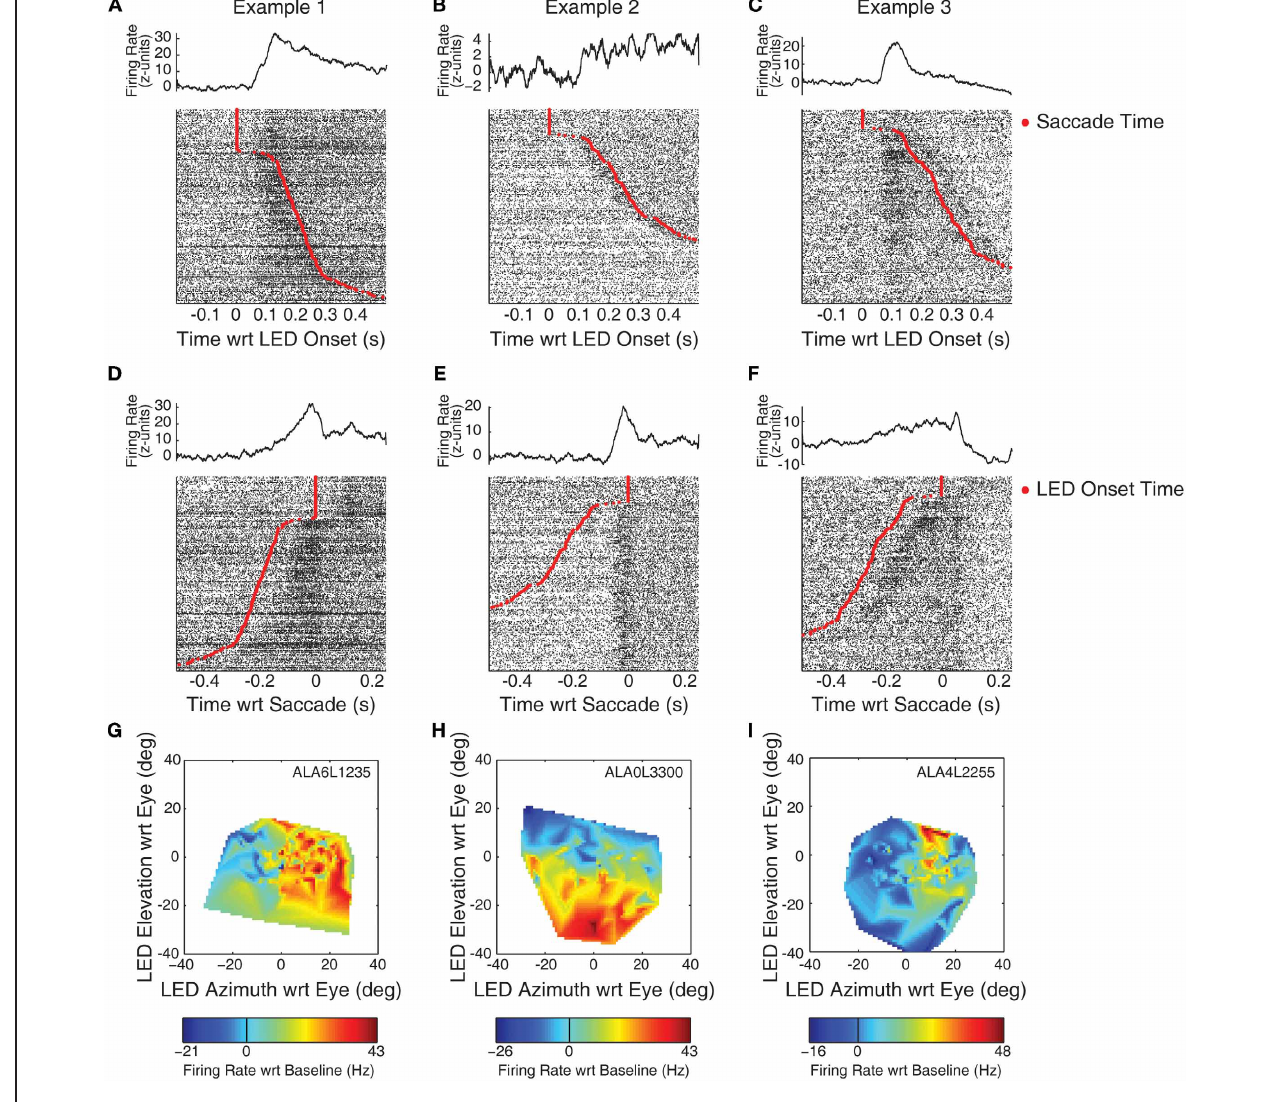
fixation window (i.e., on the red points in A – C ). Here, a seemingly motor-related response can be seen in panel (E) . Panels (G–I) indicate the spatial tuning properties of the responses using spontaneous changes in eye orientation at the time of LED onset. The ordinate and abcissa indicate the location of the fixation stimulus in eye-centered co-ordinates. Color tracks the firing rate (subtracting baseline), warmer colors indicate increases in firing rate, while cooler colors indicate